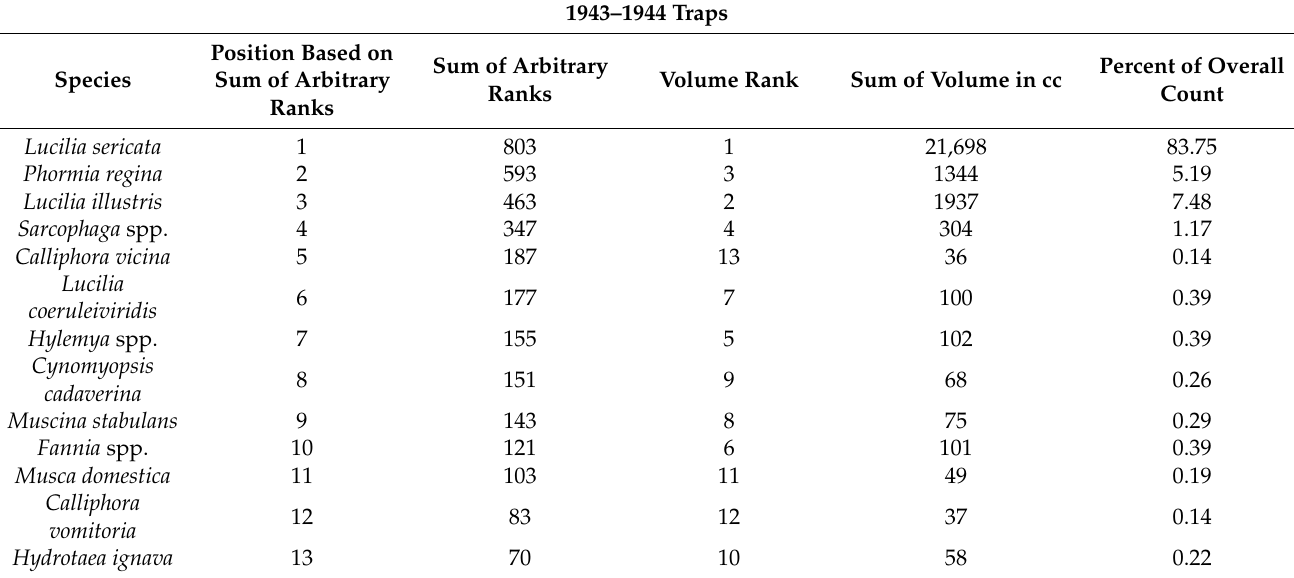
Table 2. Fly species trapped in the 1943–1944 survey.